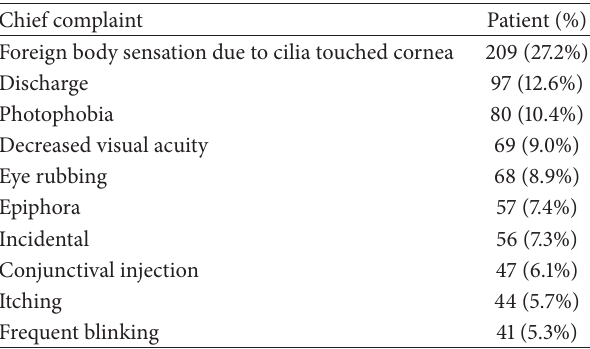
Table 2: Chief complaint of